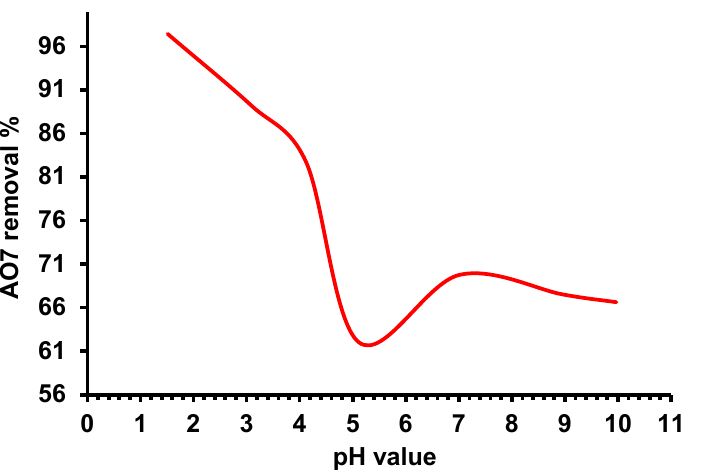
Figure 8. Effect of solution pH on the AO7 dye removal % using pea pods AC/ZnCl 2 -800 ◦ C under CO 2 (1.0 g/L) and 100 mg/L initial dye concentration at 25 ± 2 ◦ C.